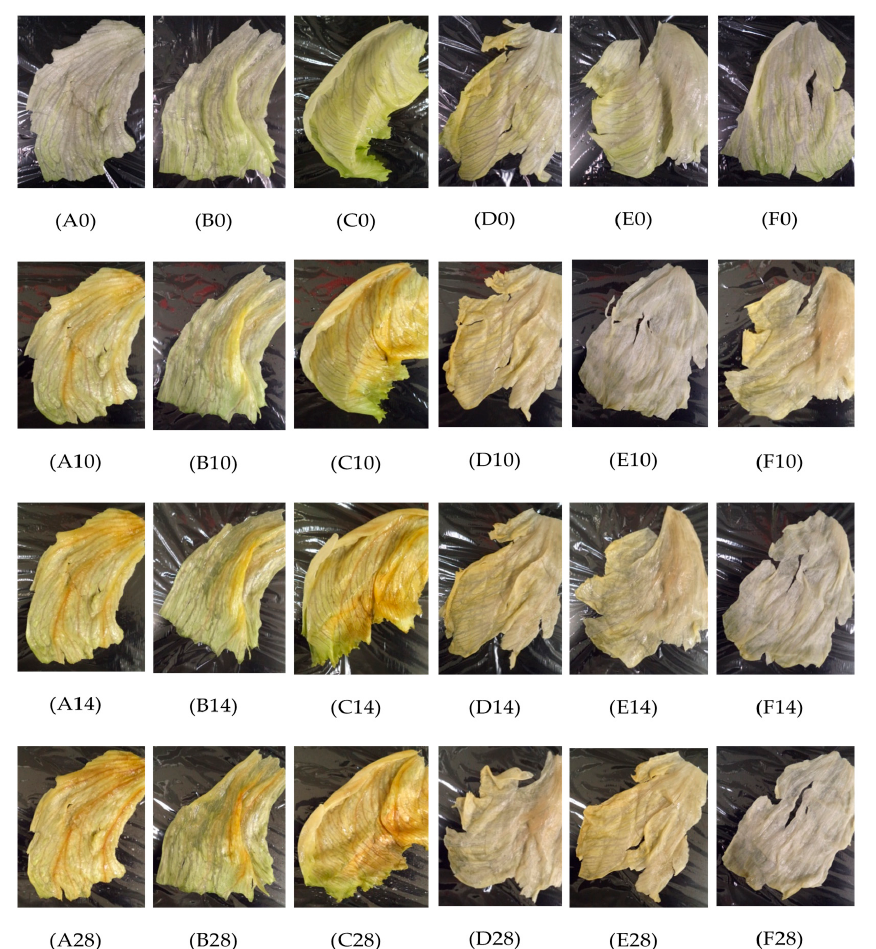
Figure 4. Visual observation of Iceberg lettuce leaves inoculated with P. fluorescens , and treated with 50 ppm chlorine, 3% hydrogen peroxide, and plant-based microemulsions and stored at 4 °C for 28 days. Letters denoted represent positive control (A0) on day 0, (A10) on day 10, (A14) on day 14, and (A28) on day 28; 50 ppm chlorine (B0) on day 0, (B10) on day 10, (B14) on day 14, and (B28) on day 28; 3% hydrogen peroxide (C0) on day 0, (C10) on day 10, (C14) on day 14, and (C28) on day 28; 0.5% cinnamon oil microemulsion (D0) on day 0, (D10) on day 10, (D14) on day 14, and (D28) on day 28; 0.3% cinnamon oil microemulsion (E0) on day 0, (E10) on day 10, (E14) on day 14, and (E28) on day 28; 0.3% oregano oil microemulsion (F0) on day 0, (F10) on day 10, (F14) on day 14, and (F28) on day 28.